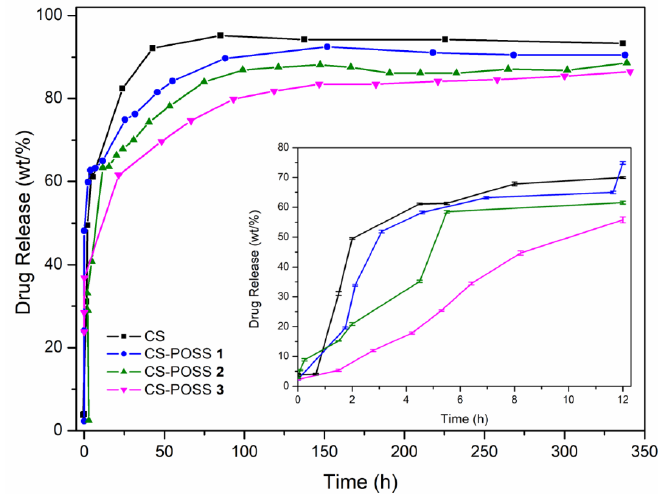
Figure 5. Ketoprofen release from CS and CS-POSS hydrogels at different POSS concentrations at 37 °C in PBS (pH 7.4). Data in the inset represent mean and standard deviation of three experiments in the first 12 h (SD ≤ 0.45).